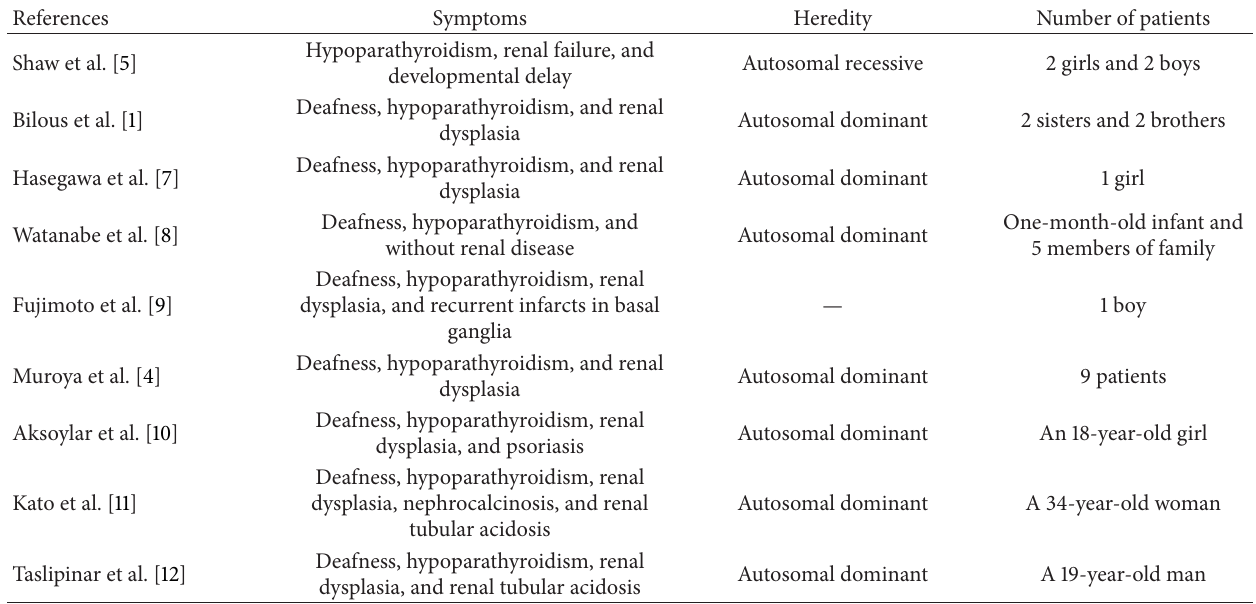
Table 1: Comparison of presentation for patients with HDR syndrome.